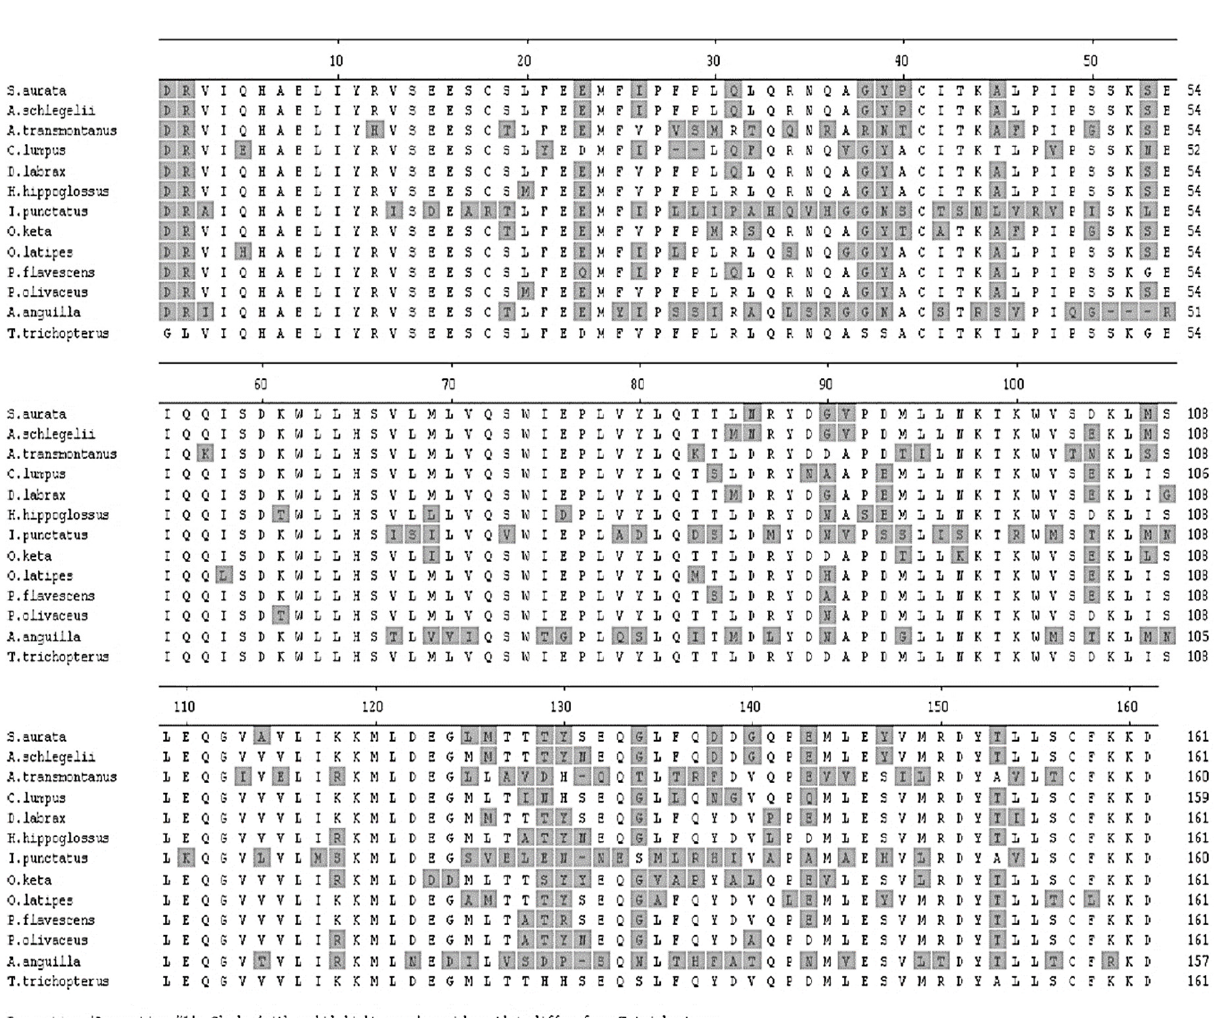
Figure 22. Comparison of cDNA sequences of somatolactin (SL) from blue gourami and various other fish species [44,45]. The phylogenetic tree showing the relationship between SL amino acid sequences compared to those of different teleosts is presented in Figure 23 [45].